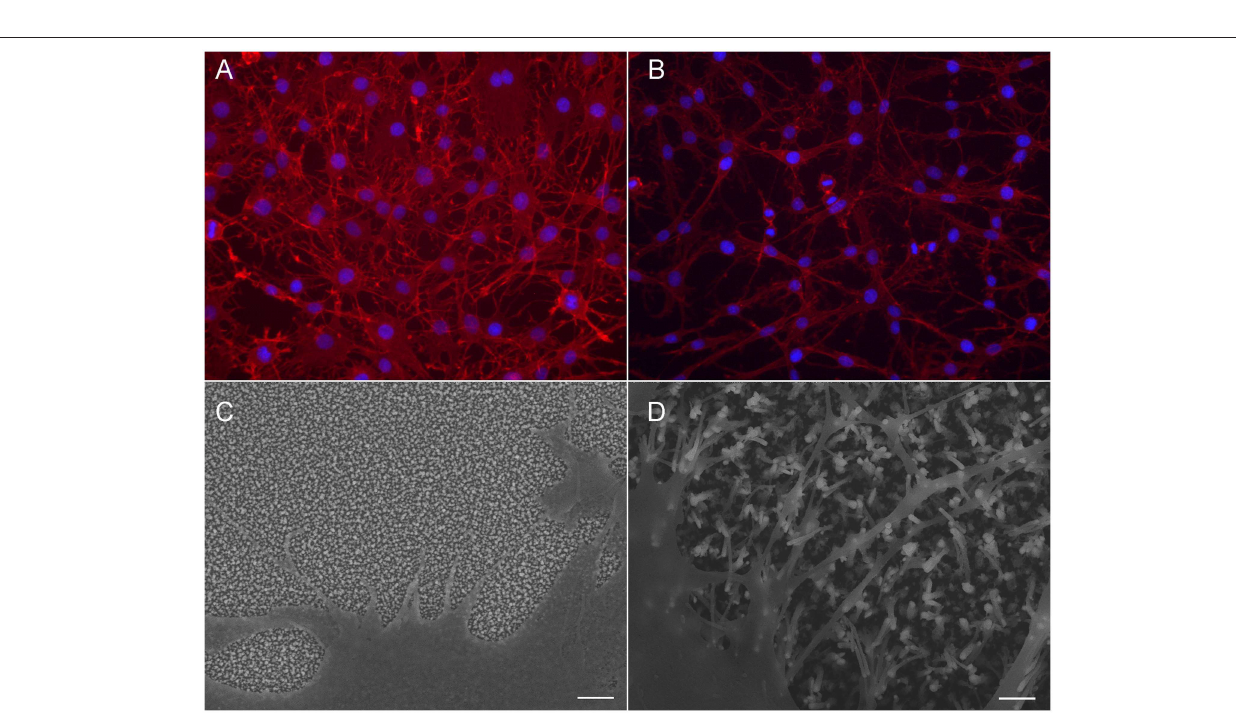
FIGURE 5 | C6 cells on CNF Pt /ta-C hybrid (A,C) and CNF Ni /ta-C hybrid (B,D) . Fluorescent image (A,B) present actin on red and nuclei on blue. Cells on CNF Ni /ta-C hybrid present elongated morphology and extensive amount of filopodia compared to cells on CNF Pt /ta-C hybrid. Scale bar in (C,D) is 1 µ m. (C,D) reproduced from Supplementary Material of Isoaho et al. (2018b)—Published by The Royal Society of